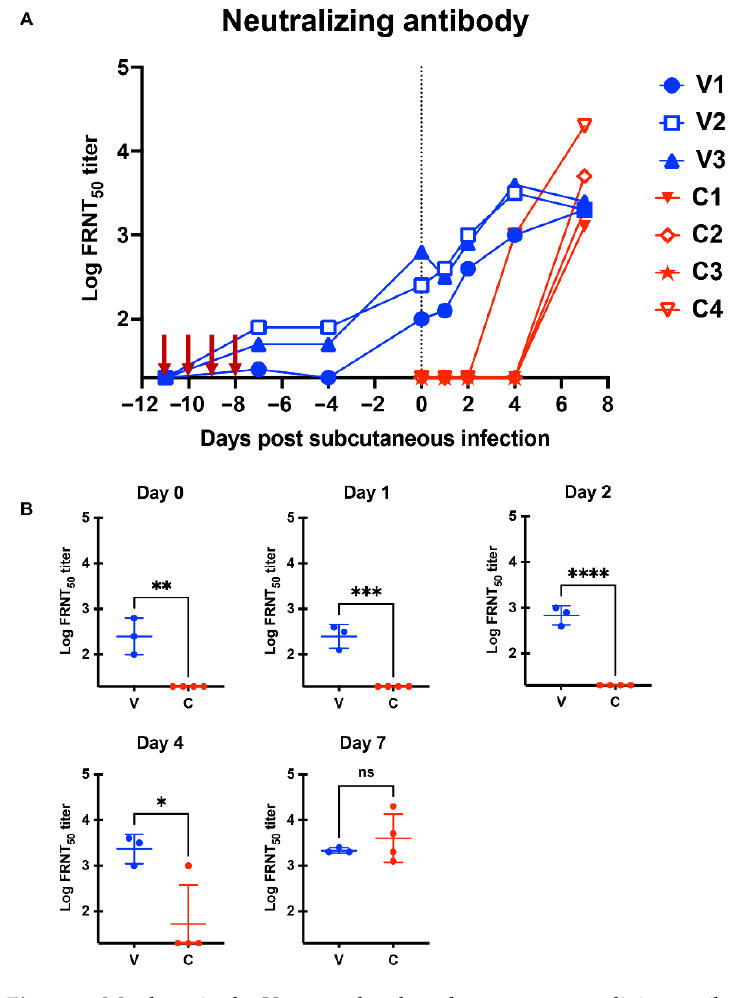
Figure 5. Monkeys in the V group developed a potent neutralizing antibody at the time of subcuta- neous superchallenge. ( A ) The focus reduction neutralization test (FRNT) 50 titers were calculated. While V1-V3 denotes each animal ID in group V (intravaginal pre-inoculation), C1-C4 denotes one in group C (control). ( B ) Differences in FRNT 50 titers on Days 0, 1, 2, 4, and 7 between groups V and C were examined by a two-tailed, unpaired Student t -test. **** p < 0.0001, *** p < 0.001, ** p < 0.01, * p < 0.05, ns (not significant).